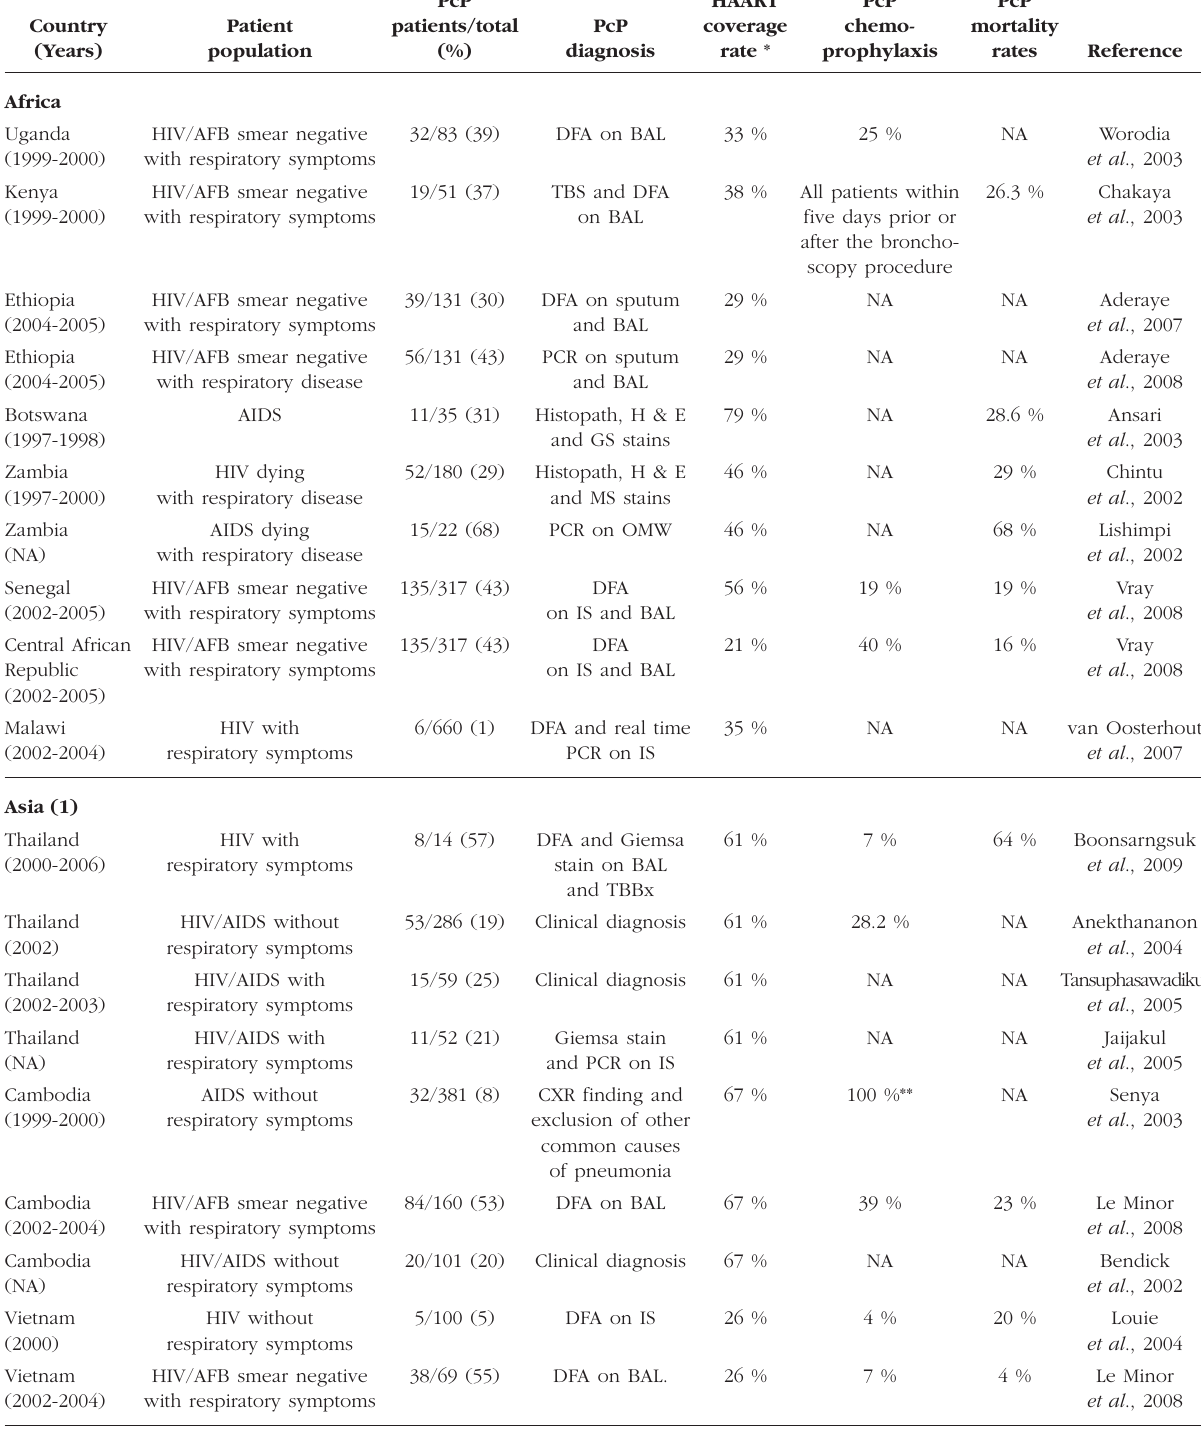
Table I. – Pneumocystis pneumonia in developing